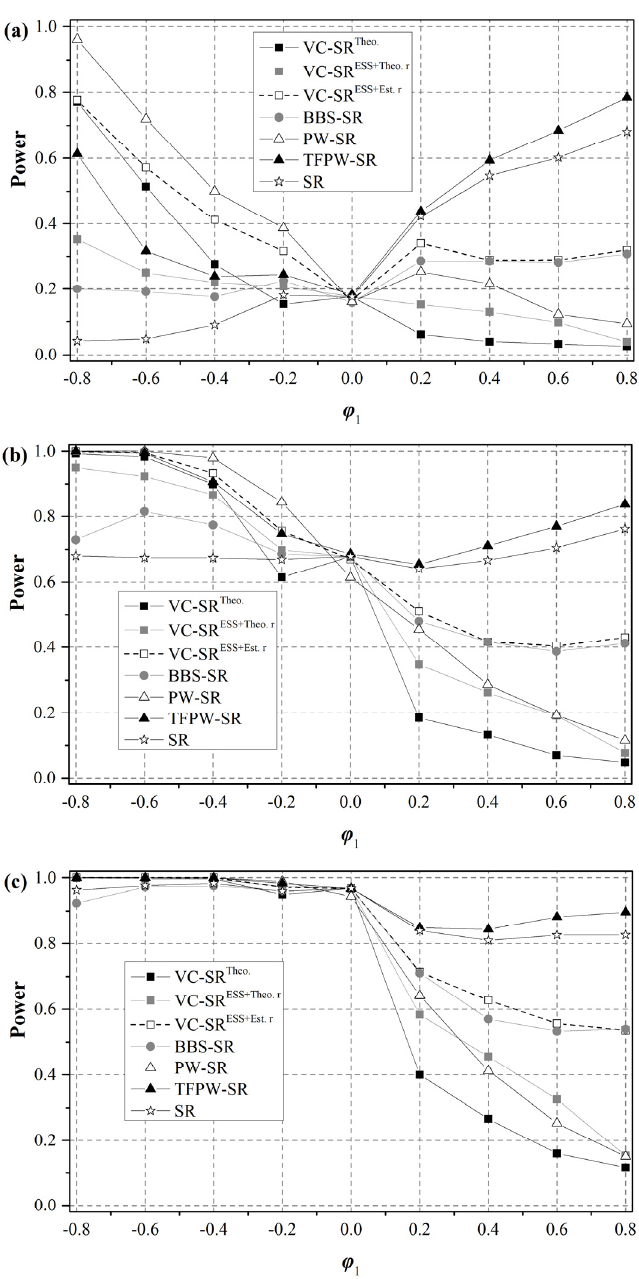
Figure 8. Comparison of power of different SR tests for AR(2) series ( n = 50): ( a ) β = 0.002; ( b ) β = 0.005; ( c ) β = 0.008.